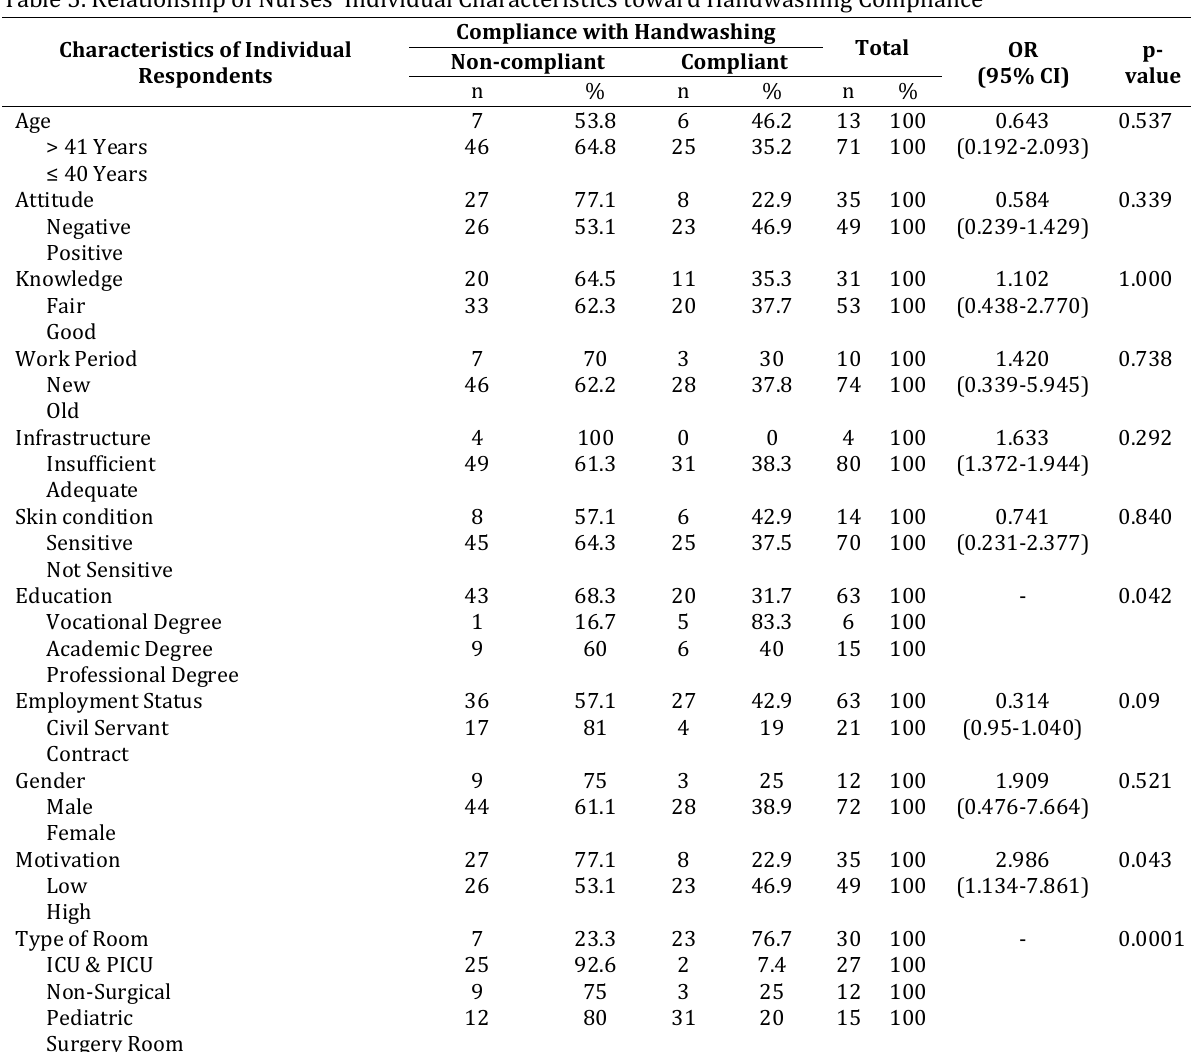
After touching the patient ’s